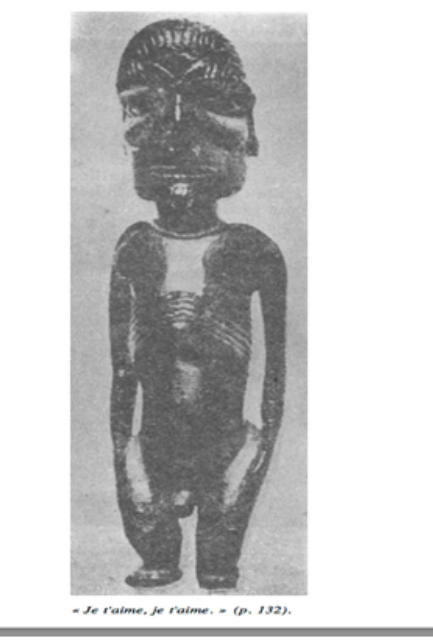
Figure 10. Anonymous. Photograph of Easter Island Sculpture in Nadja (1928) (1928)